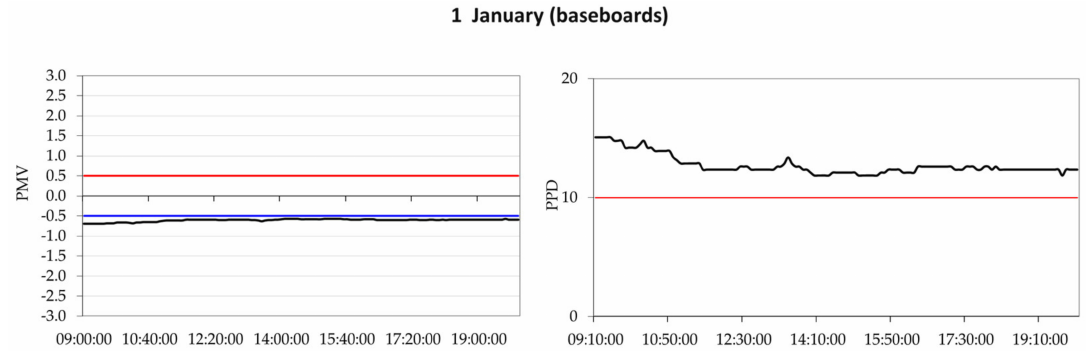
Figure 3. PMV and PPD calculation: baseboards.